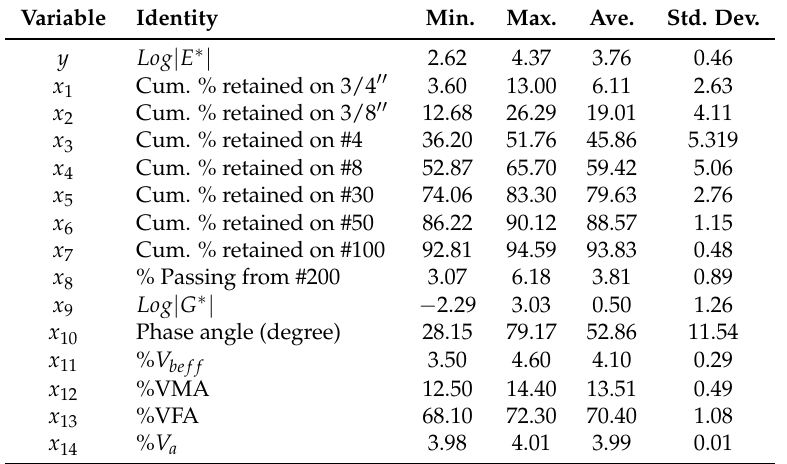
Table 2. Selected Input Variables ( x ) And Output Variable ( y ) For Model Development.